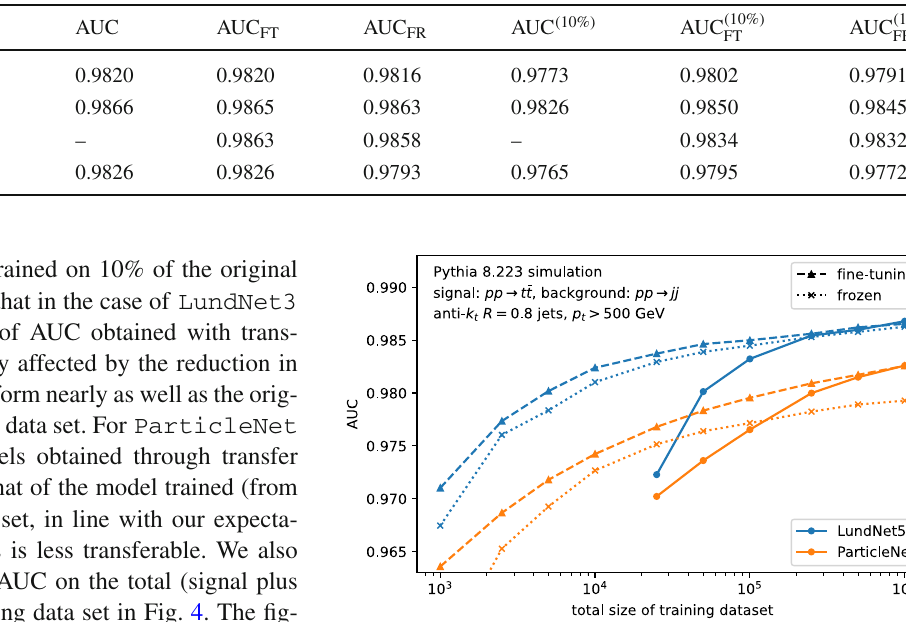
denotes the frozen-layer option, and the ( 10% ) superscript refers to results obtained with just one tenth of the original training data